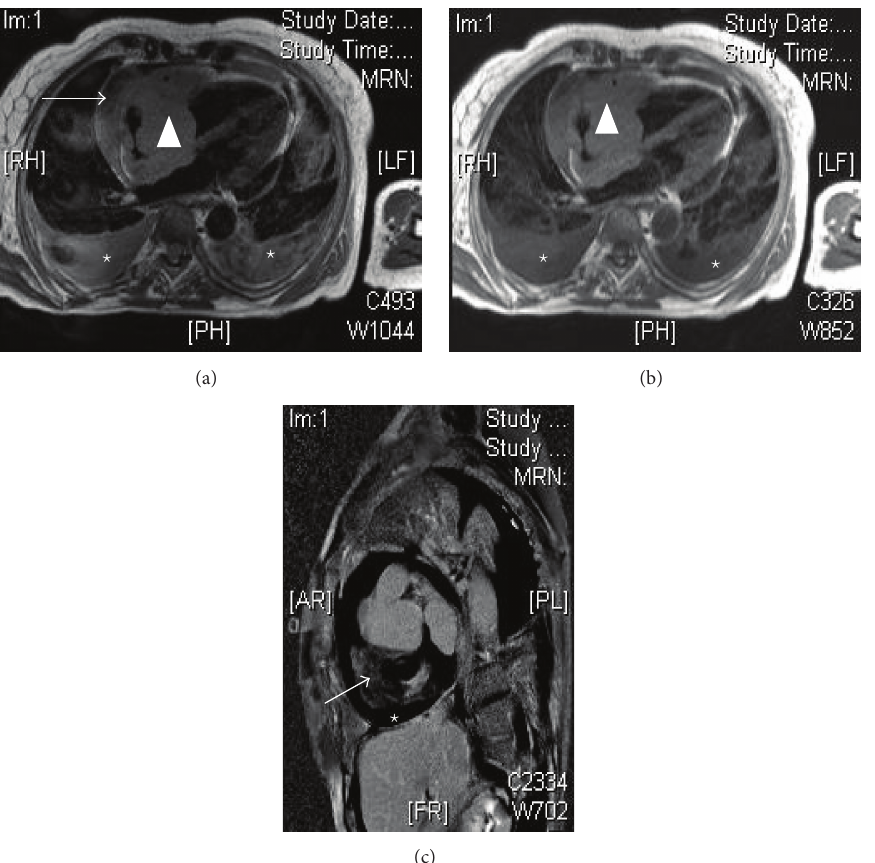
Figure 2: Cardiac magnetic resonance imaging (MRI). (a) Axial T2 cardiac section, showing an isointense homogeneous mass with respect to the RA myocardium (arrowhead), with pericardial effusion (arrow) and bilateral pleural effusion (star). (b) Axial T1 section, similar to the previous image, showing an isointense homogeneous mass with respect to the myocardium that occupies almost all of the RA, without fat infiltration (arrowhead) and bilateral pleural effusion (star). (c) shows the short-axis RV with delayed gadolinium enhancement and a pattern of diffuse and ill-defined enhancement (arrow). Pericardial effusion